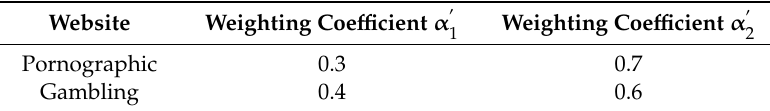
and α (cid:48) for website 2 1